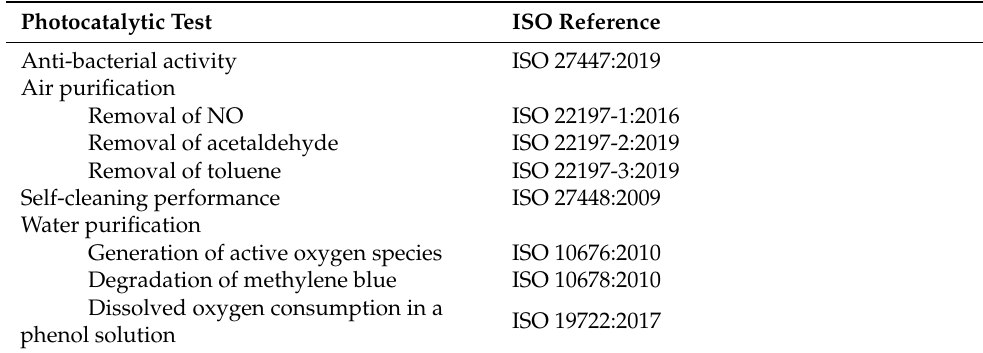
Table 1. Recommended tests for photocatalytic materials according to the International Organization for